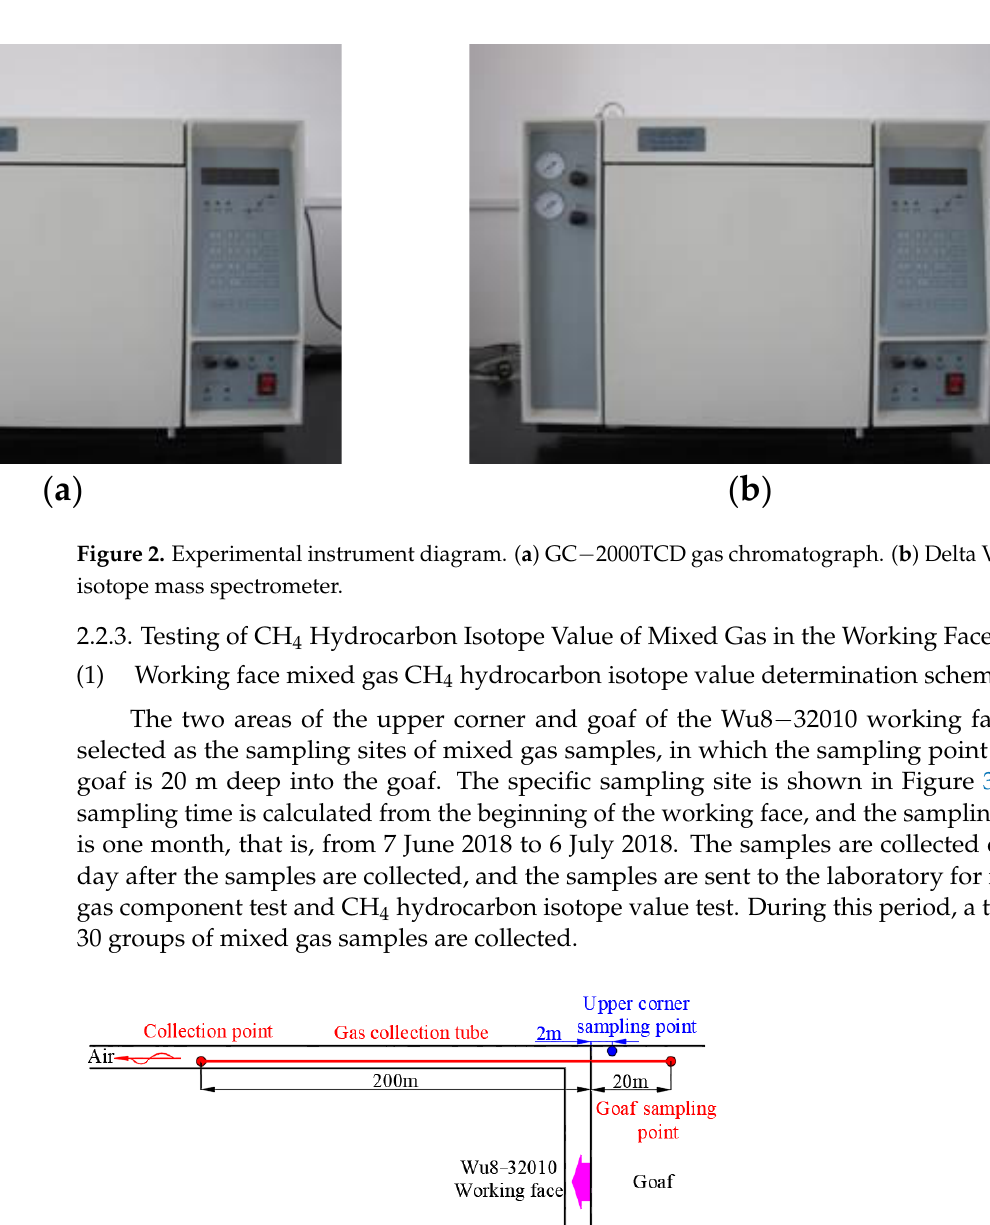
Figure 3. Mixed gas sample collection location diagram. (2)